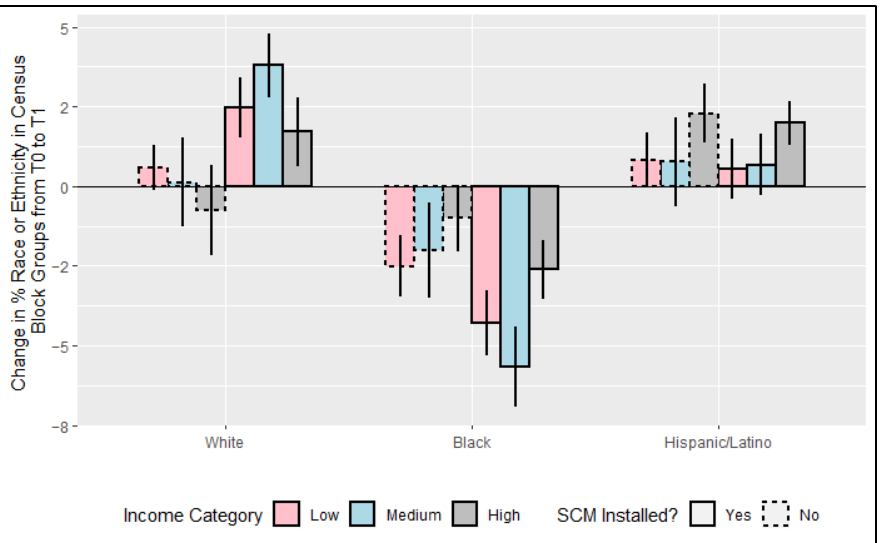
Figure 4. Change in percent of residents who are White, Black, and Hispanic/Latino in Census block groups with and without stormwater control measure (SCM) installations with pre-existing income